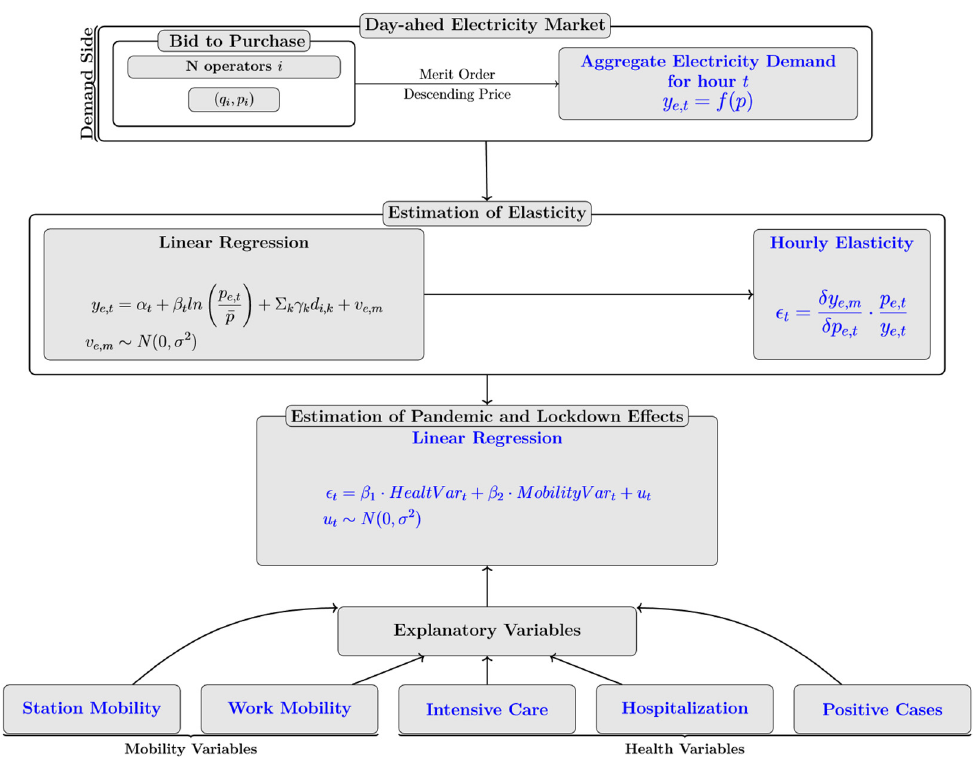
Figure 1. Flowchart summarizing the main stages of the study.